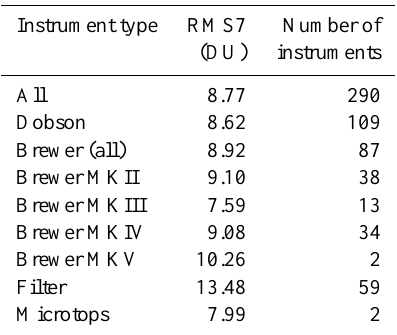
Table 5. Noise figures of the ground network compared to MSR level